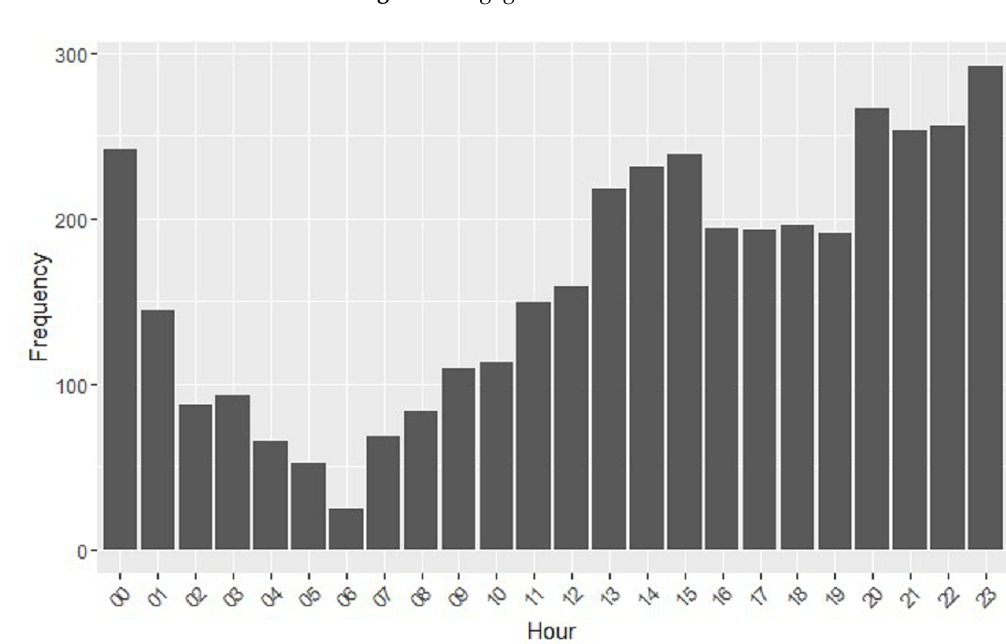
Figure 3. Frequency vs.